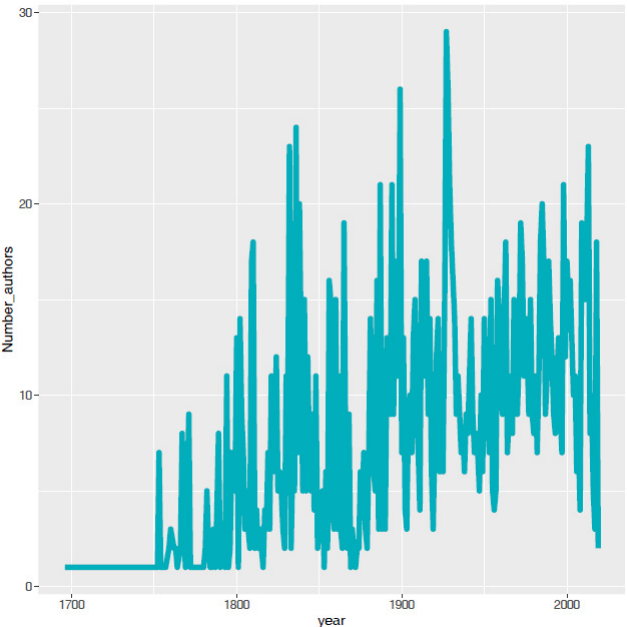
Figure 7. Changes in number of authors who describe all South Africa’s native species